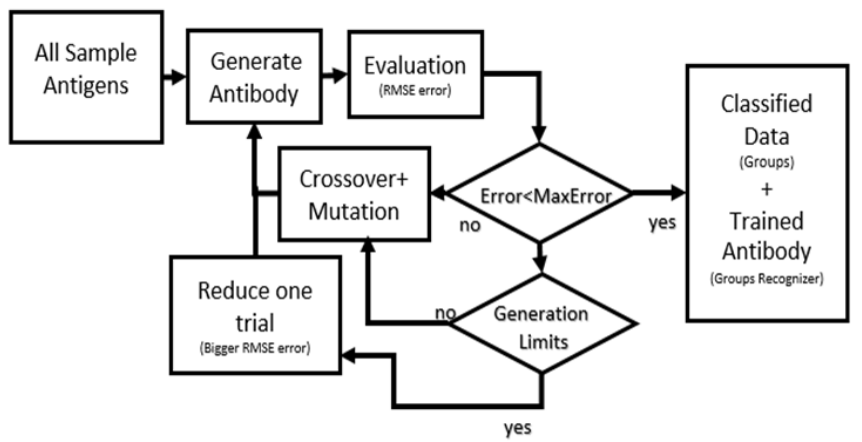
Figure 2. Data flowchart steps using IA. Each antigen-antibody interaction is evaluated using root- mean-square error to quantify this interaction sample by sample. After the evaluation process, a new group of samples is created if the mean of all RMSE is satisfactory. If the mean of all RMSE does not achieve the goal, one sample would be removed from the database, and the process is restarted until a new group is achieved. All removed samples were submitted again to the same process separately until all samples were